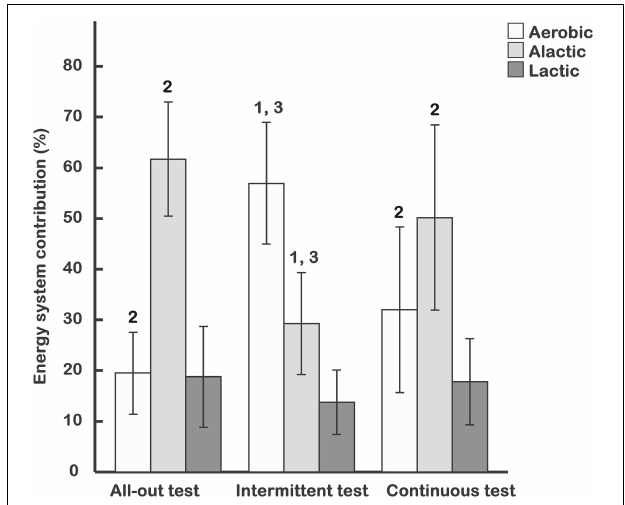
FIGURE 2 | Aerobic, alactic, and lactic relative energy contributions (mean ± SD) in 3 exercise tests proposed for climbers. 2—when significantly different ( p < 0.05) from the intermittent test; 1, 3—when significantly different ( p < 0.05) from the all-out and continuous test,